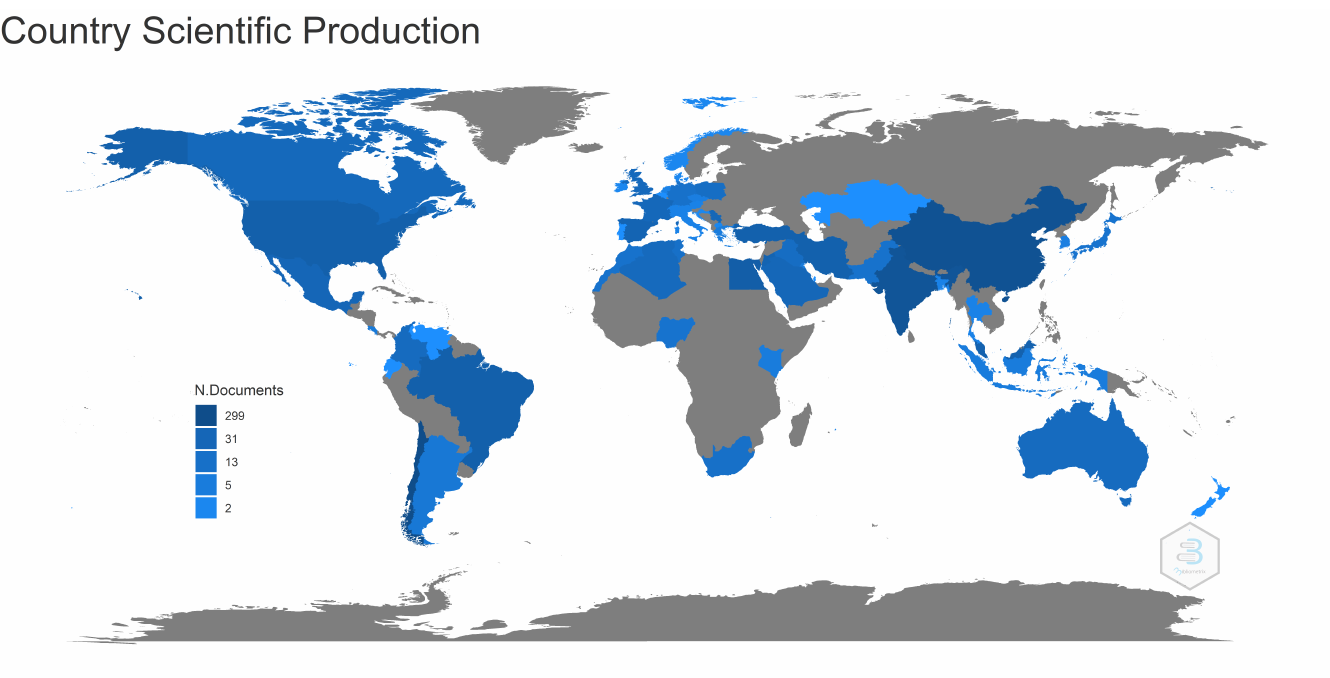
Figure 3. Scientific production by